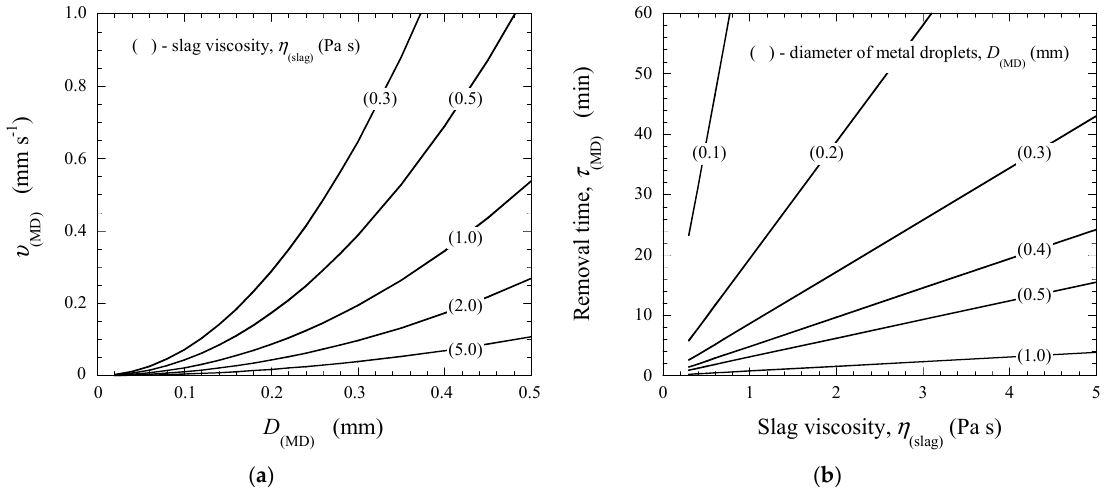
Figure 6. Calculated velocity, υ (MD) , and time, τ (MD) , for the removal of metal droplets from the liquid slag depending on the size of metal droplets, D (MD) ( a ), and the slag viscosity, η (slag) ( b ). It was found that all droplets larger than 0.3 mm can be separated completely from LVS slags at around 9 min because the minimum values of υ (MD) for D (MD) = 0.3 mm are almost 0.2 mm·s − 1 . However, the metal droplets with a size of smaller than 0.3 mm can only be partially removed. This is due to the fact that the τ (MD) value varies from 3 to 77 min for D (MD) = 0.29 and 0.1 mm,